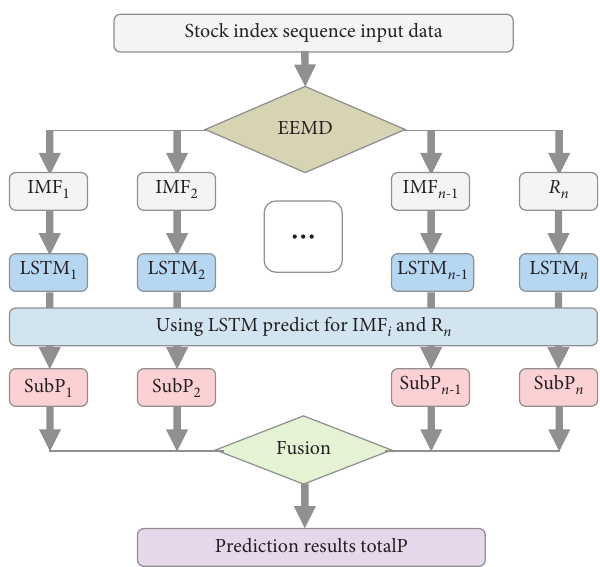
Figure 6: The structure and process of the LSTM-EEMD